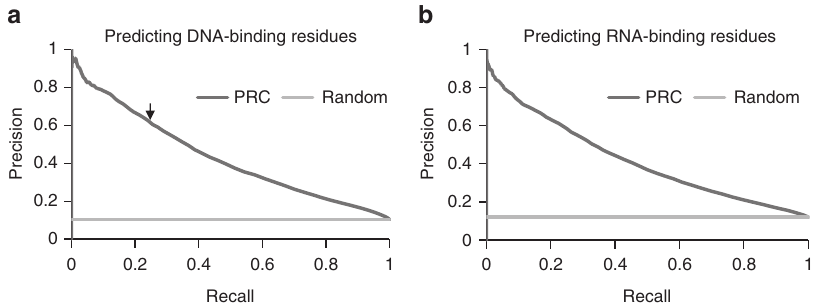
Figure 1 | Precision-recall curves (PRC) for predicting NA binding residues. ( a ) PRC for DNA-binding residues prediction. Arrow marks the cutoff score that yielded precision of 0.65 and recall of 0.23 ( b ). PRC for RNA-binding residues prediction.